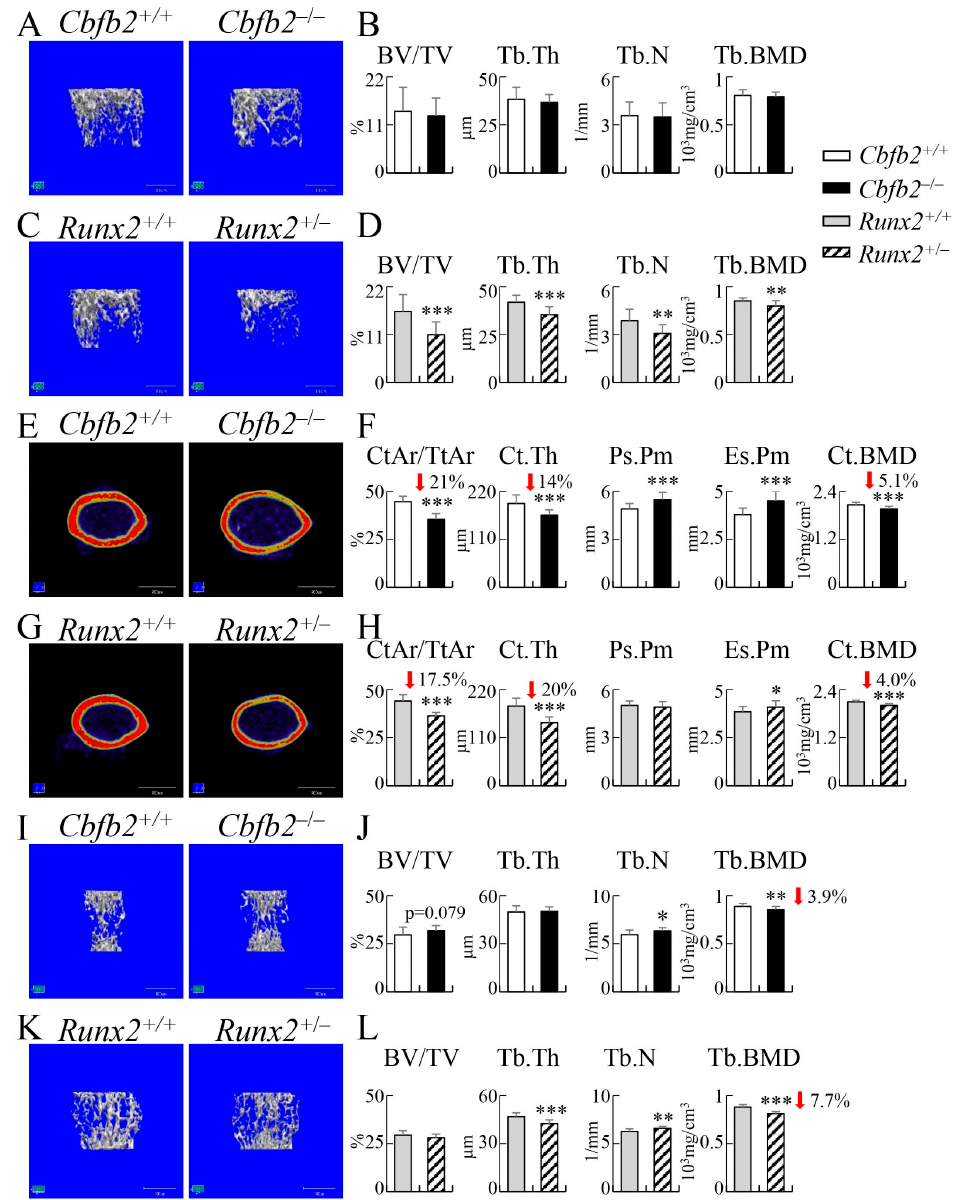
Figure 11. Micro ‐ CT analyses of femurs and lumbar vertebrae in male mice at 10 weeks of age. ( A – D ) Three ‐ dimensional trabecular bone architecture of distal femoral metaphysis ( A , C ) and quantification of the trabecular bone volume (bone volume/tissue volume, BV/TV), trabecular thickness (Tb.Th), trabecular number (Tb.N) and trabecular bone mineral density (Tb.BMD) in Cbfb2 +/+ and Cbfb2 –/– mice ( B ) and Runx2 +/+ and Runx2 +/– mice ( D ). ( E – H ) Micro ‐ CT images of the cortical bone at mid ‐ diaphysis in femurs ( E , G ) and quantification of the cortical area (CtAr/TtAr), cortical thickness (Ct.Th), periosteal perimeter (Ps.Pm), endosteal perimeter (Es.Pm) and cortical bone mineral density (Ct.BMD) in Cbfb2 +/+ and Cbfb2 –/– mice ( F ) and Runx2 +/+ and Runx2 +/– mice ( H ). The number of mice analyzed: Cbfb2 +/+ , n = 19; Cbfb2 –/– , n = 14; Runx2 +/+ , n = 17; Runx2 +/– , n = 15. ( I – L ) Three ‐ dimensional trabecular bone architecture of 6th lumbar vertebrae ( I , K ) and trabecular bone parameters in Cbfb2 +/+ and Cbfb2 –/– mice ( J ) and 1st lumbar vertebrae of those parameters in Runx2 +/+ and Runx2 +/– mice ( L ). Scale bars: 1 mm ( A , C , E , G ) and 0.5 mm ( I , K ). Data are shown as the mean ± SD. * p < 0.05, ** p < 0.01 and *** p < 0.001. The number of mice analyzed: Cbfb2 +/+ , n = 9; Cbfb2 –/– , n = 14; Runx2 +/+ , n = 14; Runx2 +/– , n =13.